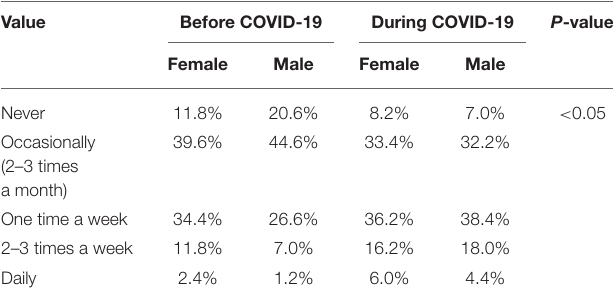
TABLE 2 | The frequency of negative feelings associated with the disease in the study group (according to AIS)— N =